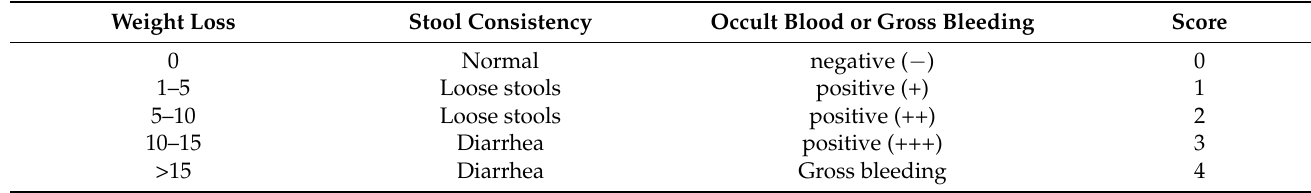
Table 1. Criteria for scoring disease activity